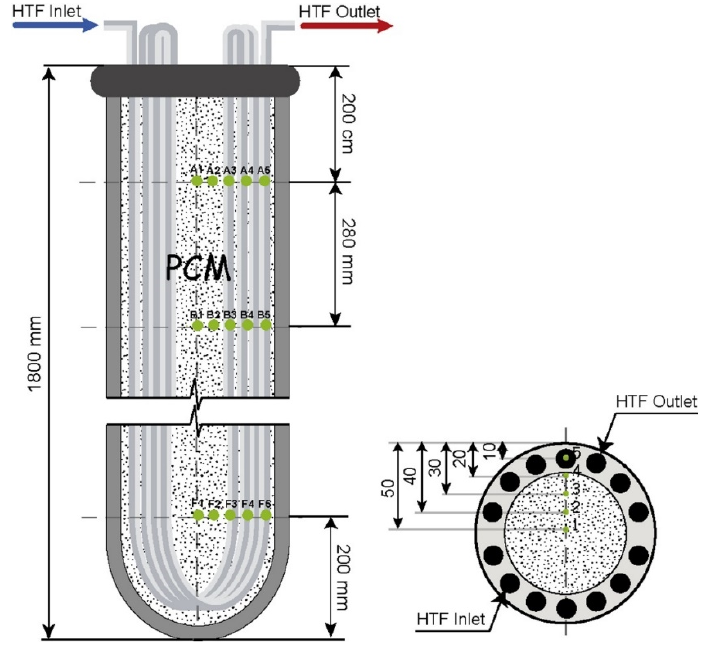
Figure 15. The LHTES studied by Osman et al. [51].